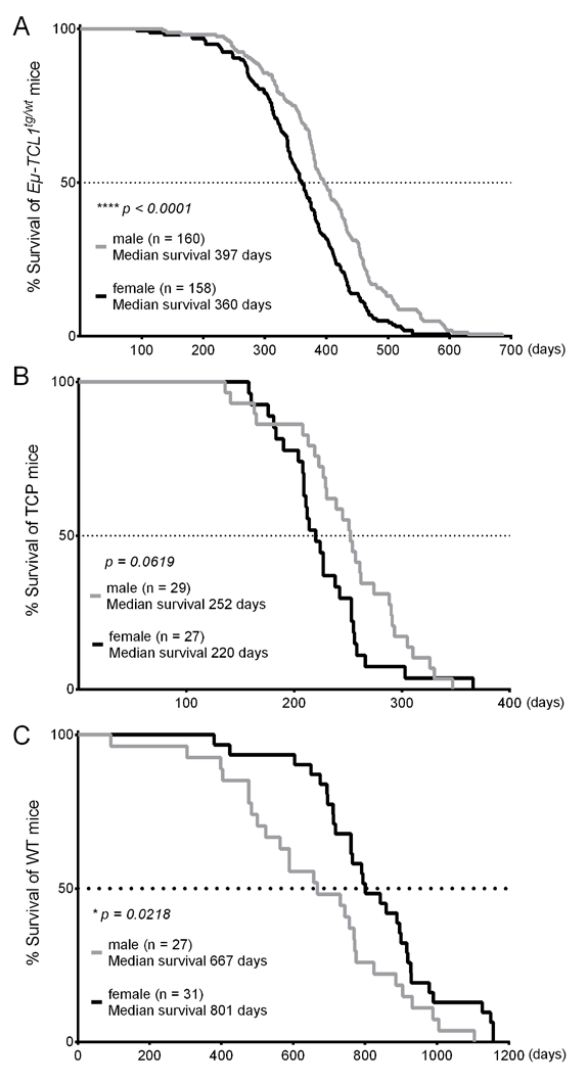
Figure 2. Significant sex di ff erence in the overall survival of E µ -TCL1 tg / wt and E µ -TCL1 tg / wt ; CD19Cre Cre / wt ; Trp53 fl / fl (TCP) mice. ( A ) Kaplan–Meier curves representing the overall survival of 160 male and 158 female E µ -TCL1 tg / wt mice showed significantly longer survival of males than females. Median survival: E µ -TCL1 tg / wt males = 397 days; E µ -TCL1 tg / wt females = 360 days. Mantel–Cox logrank test: **** p < 0.0001. ( B ) Kaplan–Meier curves representing the overall survival of 29 male and 27 female TCP mice demonstrating the longer survival of males than females. Median survival: TCP males = 252 days; TCP females = 220 days; Mantel–Cox logrank test: p = 0.0619. ( C ) Kaplan–Meier curves representing the overall survival of 27 male and 31 female wild type (WT) mice showed significantly longer survival of females compared to males, in contrast to the sex di ff erence observed in the E µ -TCL1 transgenic mice. Median survival: WT males = 667 days, WT females = 801 days; Mantel–Cox logrank test: * p = 0.0218. Table 2. Characteristics of the analyzed E µ -TCL1 tg / wt ; CD19Cre Cre / wt ; Trp53 fl / fl (TCP) mice. Genetic No. Ref.